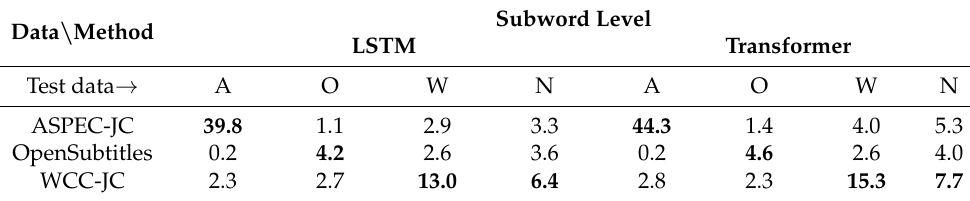
Table 7. Chinese → Japanese translation experiment results in subword level (BLEU values).